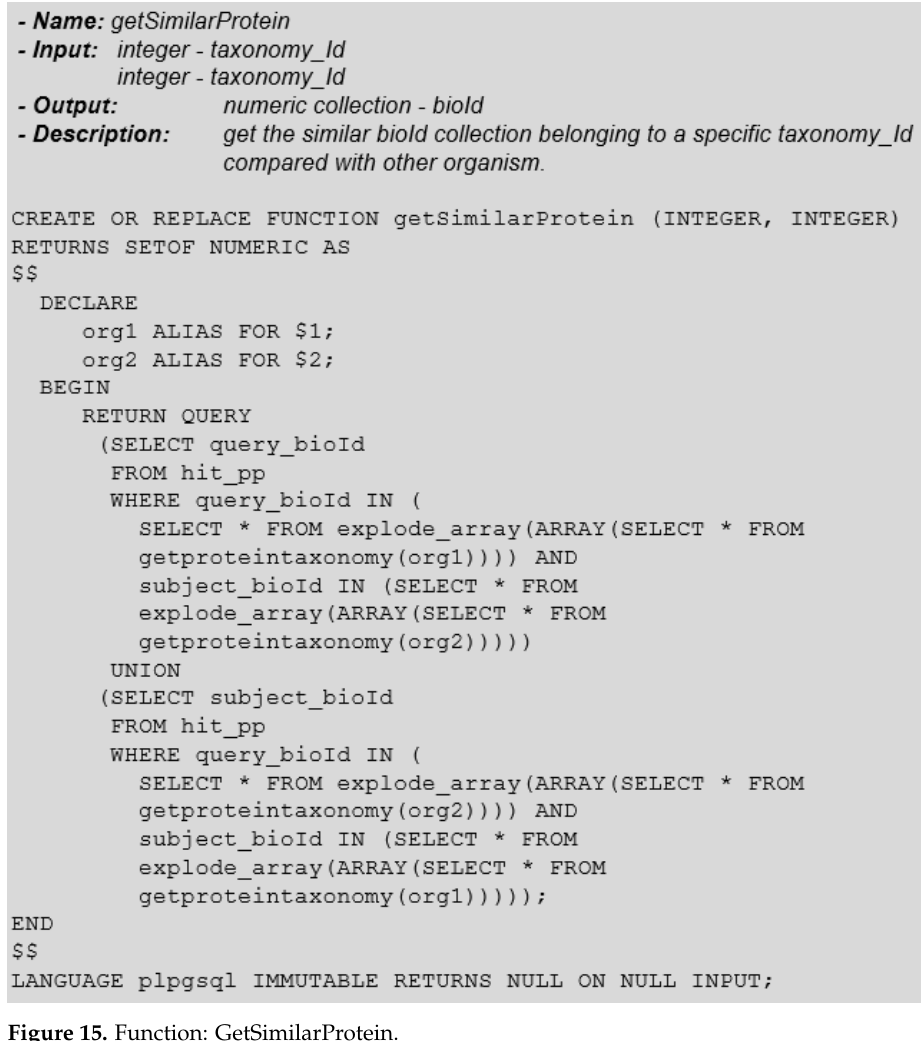
Figure 15. Function: